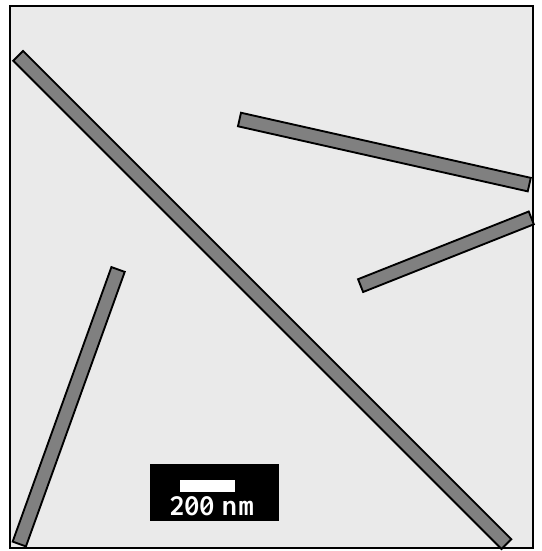
Figure 2. A schematic image of CeO membranes (AAM) as